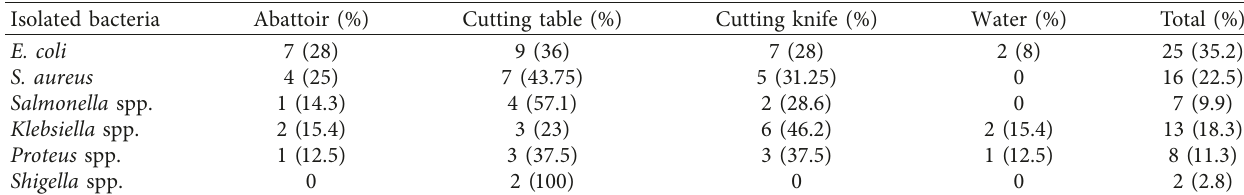
Figure 2: Characteristics of the bacterial load distribution described in mean and standard deviation. Table 5: Isolated bacteria from collected